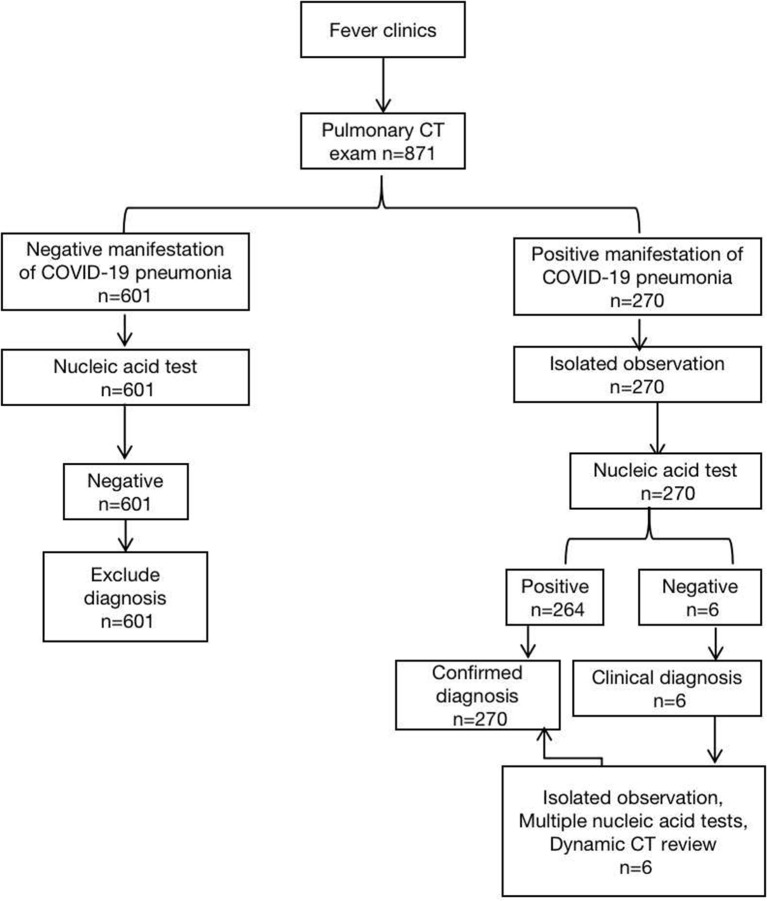
Flow chart of CT examination of fever clinics in Hubei Province.